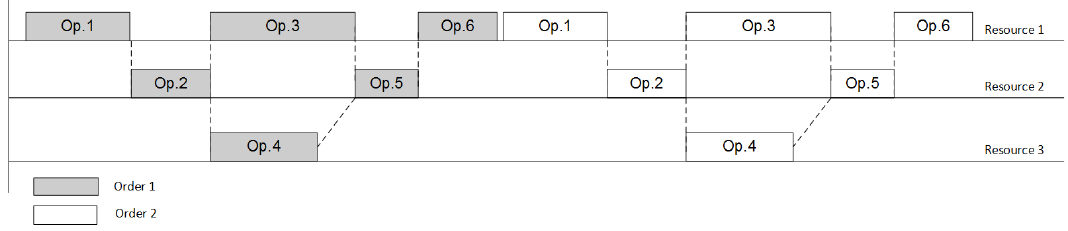
Figure 2. Initial state: all orders are placed in a